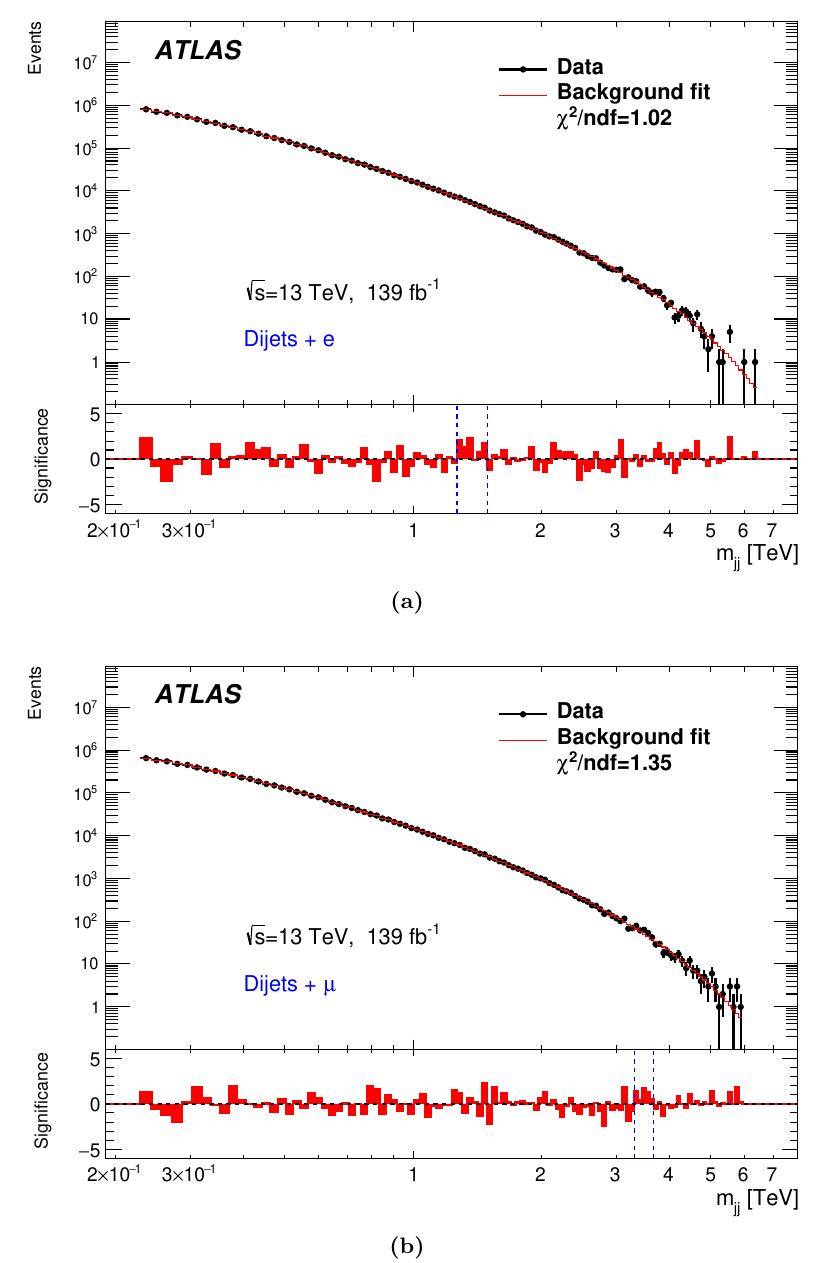
Figure 3. Dijet invariant-mass distributions for events with a high- p T (a) electron or (b) muon. The distributions are calculated from the two leading jets selected from events with at least one isolated lepton with p ‘ > 60 GeV. In each case, the result of the (cid:12)t to the (cid:12)ve-parameter background T function is also shown. The lower panels show the bin-by-bin signi(cid:12)cances of deviations from the background hypothesis. The largest deviations reported by BumpHunter are indicated by the vertical dashed lines. The global p -values of the deviations are 0.12 (for electrons) and 0.63 (for muons).